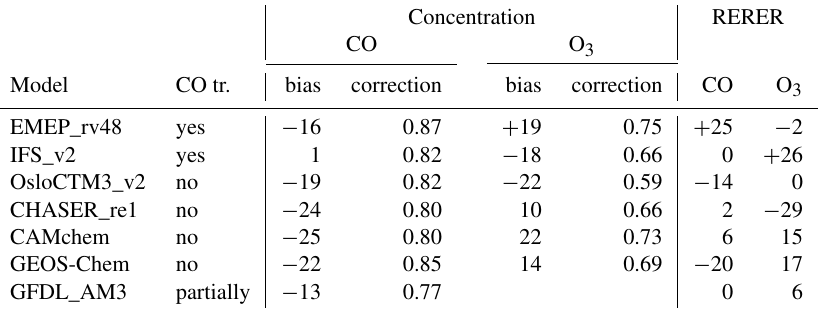
Table 5. Models to measurements bias in percent for 18 European CO sites and 113 European ozone sites. RERER is the deviation from model average in percent. Percentage deviations more than 15% preceded by ± signs in bold. CO tr. is whether the CO tracer is included. Concentration RERER CO O 3 Model CO tr. bias correction bias correction CO EMEP_rv48 yes −